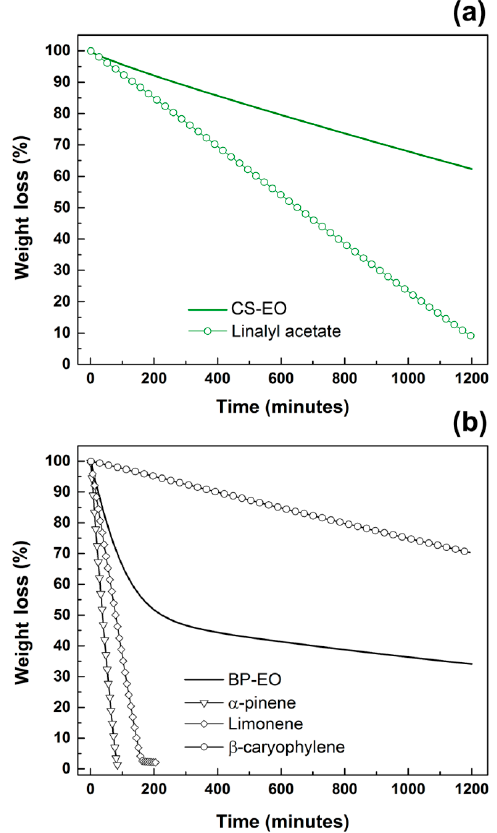
Figure 3. TGA curves of ( a ) clary sage EO and linalyl acetate; ( b ) black pepper EO, α -pinene, limonene and β -caryophyllene.